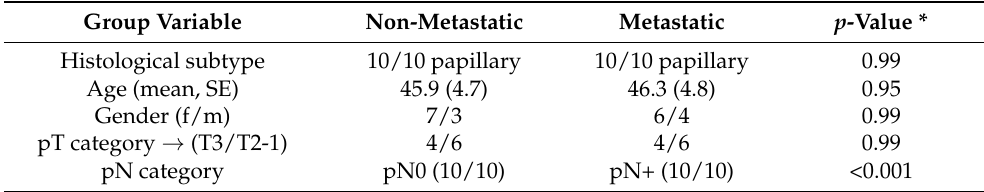
Table 1. Clinicopathological characteristics of the patients with metastatic and non-metastatic PTC analyzed by RNAseq. Group